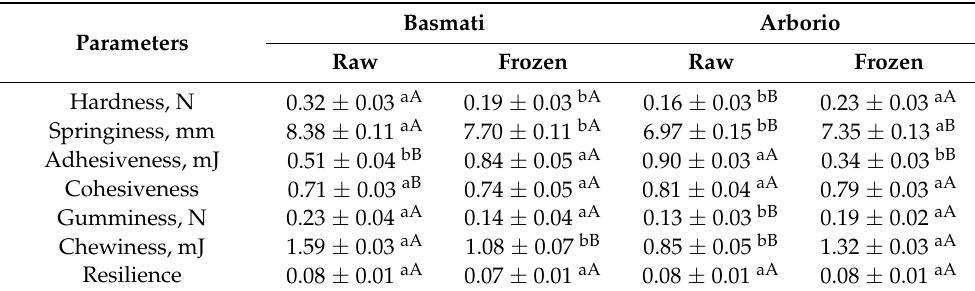
Table 5. Texture properties of flours gels obtained from raw and frozen Basmati and Arborio rice samples. Basmati Arborio Parameters Raw Frozen Raw Frozen Hardness, N 0.32 ± 0.03 aA 0.19 ± 0.03 bA 0.16 ± 0.03 bB 0.23 ± 0.03 aA Springiness, mm 8.38 ± 0.11 aA 7.70 ± 0.11 bA 6.97 ± 0.15 bB 7.35 ± 0.13 aB Adhesiveness, mJ 0.51 ± 0.04 bB 0.84 ± 0.05 aA 0.90 ± 0.03 aA 0.34 ± 0.03 bB Cohesiveness 0.71 ± 0.03 aB 0.74 ± 0.05 aA 0.81 ± 0.04 aA 0.79 ± 0.03 aA Gumminess, N 0.23 ± 0.04 aA 0.14 ± 0.04 aA 0.13 ± 0.03 bB 0.19 ± 0.02 aA Chewiness, mJ 1.59 ± 0.03 aA 1.08 ± 0.07 bB 0.85 ± 0.05 bB 1.32 ± 0.03 aA Resilience 0.08 ± 0.01 aA 0.07 ± 0.01 aA 0.08 ± 0.01 aA 0.08 ± 0.01 aA Data expressed as mean ± standard deviation ( n = 3). * Within a row, mean values corresponding to the same rice variety, which do not share a superscript lowercase letter are significantly different ( p < 0.05). Within a row,